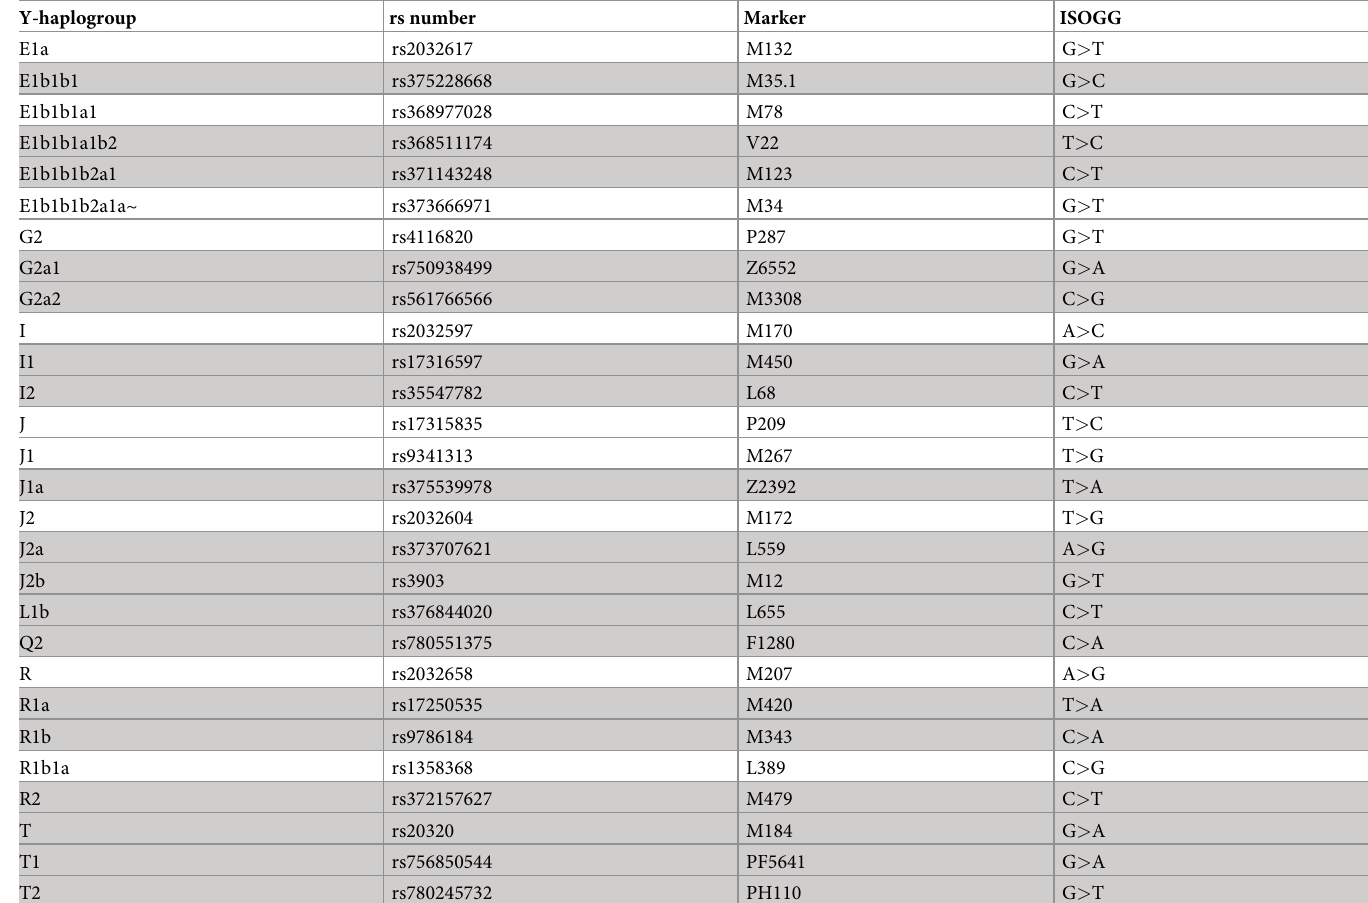
Table 1. Y SNPs used for Y-haplogroup subclade assignment.